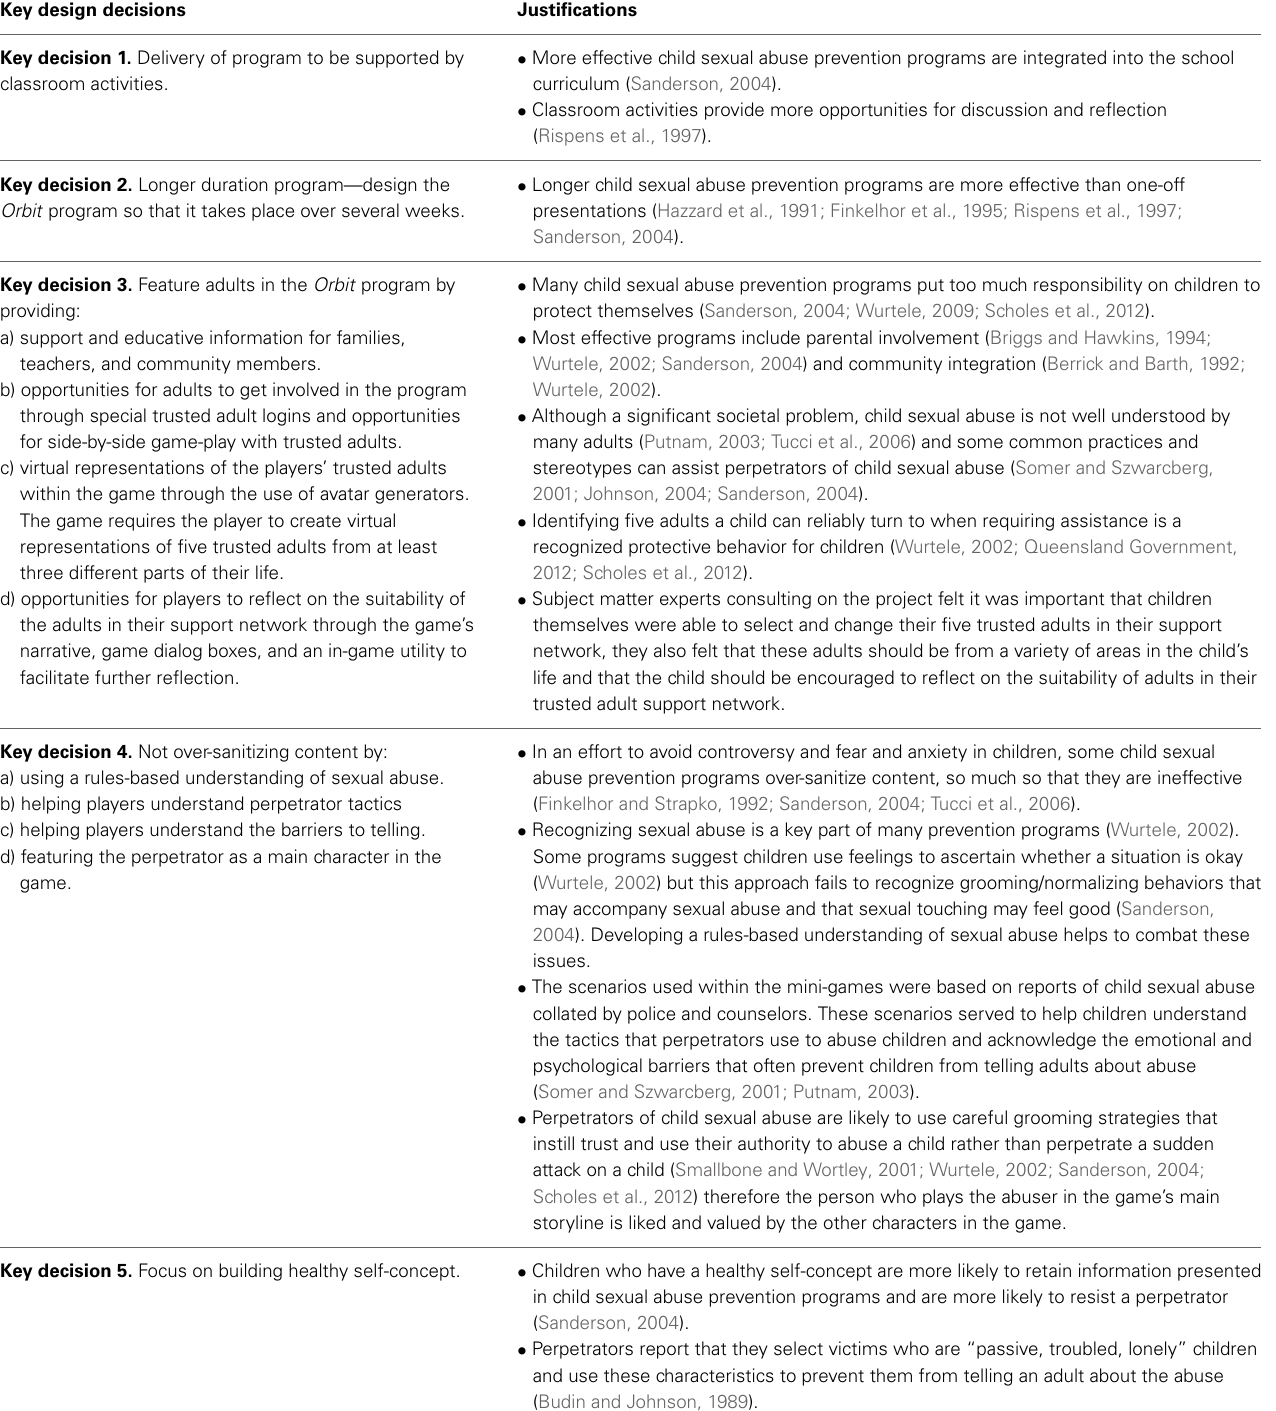
Table 1 | Key design decisions and their